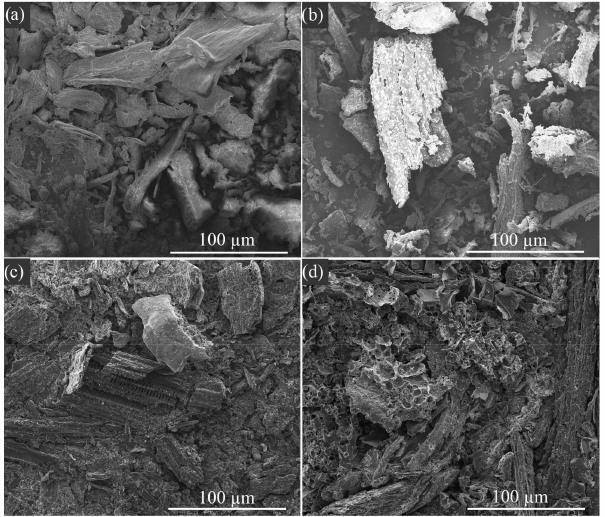
Figure 5. SEM images of the wheat straw (WS) ( a ) raw, ( b ) WS_400, ( c ) WS_500, ( d ) after